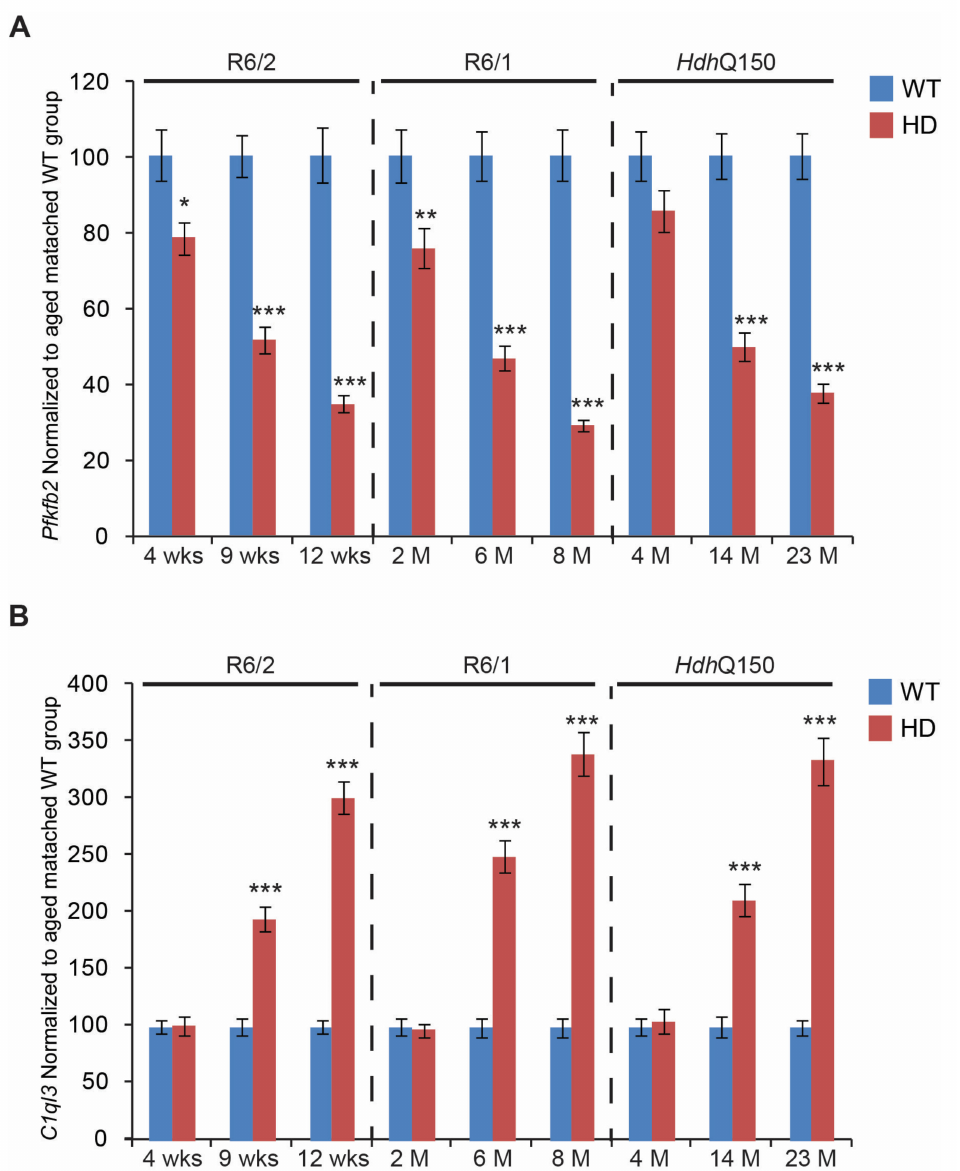
Figure 6. Transcriptional alterations of genes involved in energy homeostasis. Transcripts of ( A ) Pfkfb2 (6-phosphofructo-2-kinase/fructose-2,6-biphosphatase2) and ( B ) C1ql3 (Complement Component1, Q Sup-component-Like 3), were assessed in the eyes of three HD mouse models at: pre-symptomatic stage (4 weeks R6/2 mice, 2 months R6/1 mice, and 4 months Hdh Q150 mice); symptomatic stage (9 weeks R6/2 mice, 6 months R6/1 mice, and 14 months Hdh Q150 mice), and end-stage (12 weeks R6/2 mice, 8 months R6/1 mice, and 23 months Hdh Q150 mice). All Taqman qPCR values were normalized to the geometric mean of three housekeeping genes, as indicated in the Material and Methods section. Error bars are ± SEM (n = 6). SEM represents biological replicates. Student’s t -test: * p < 0.05, ** p < 0.01; *** p <